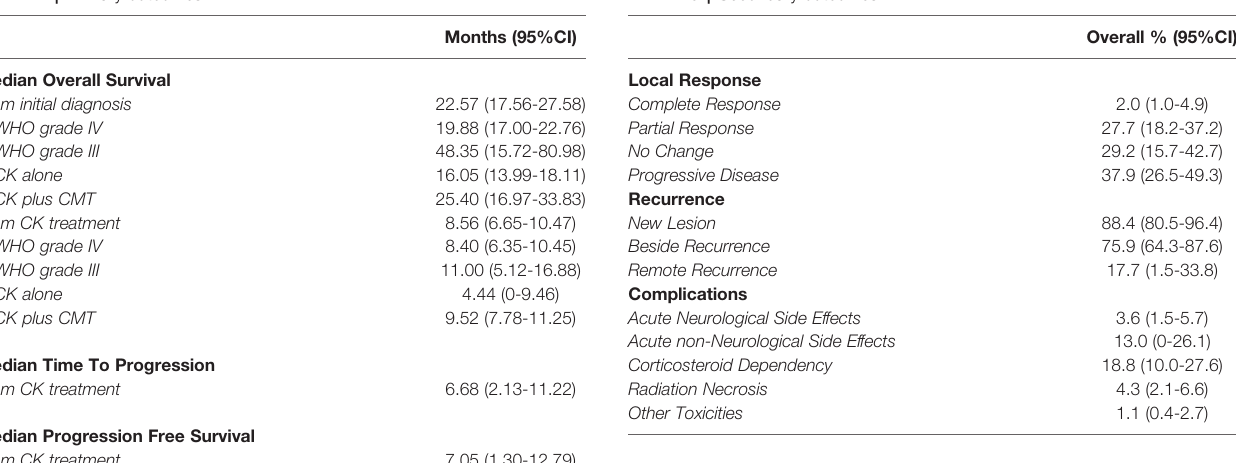
TABLE 2 | Primary outcomes. TABLE 3 | Secondary outcomes.